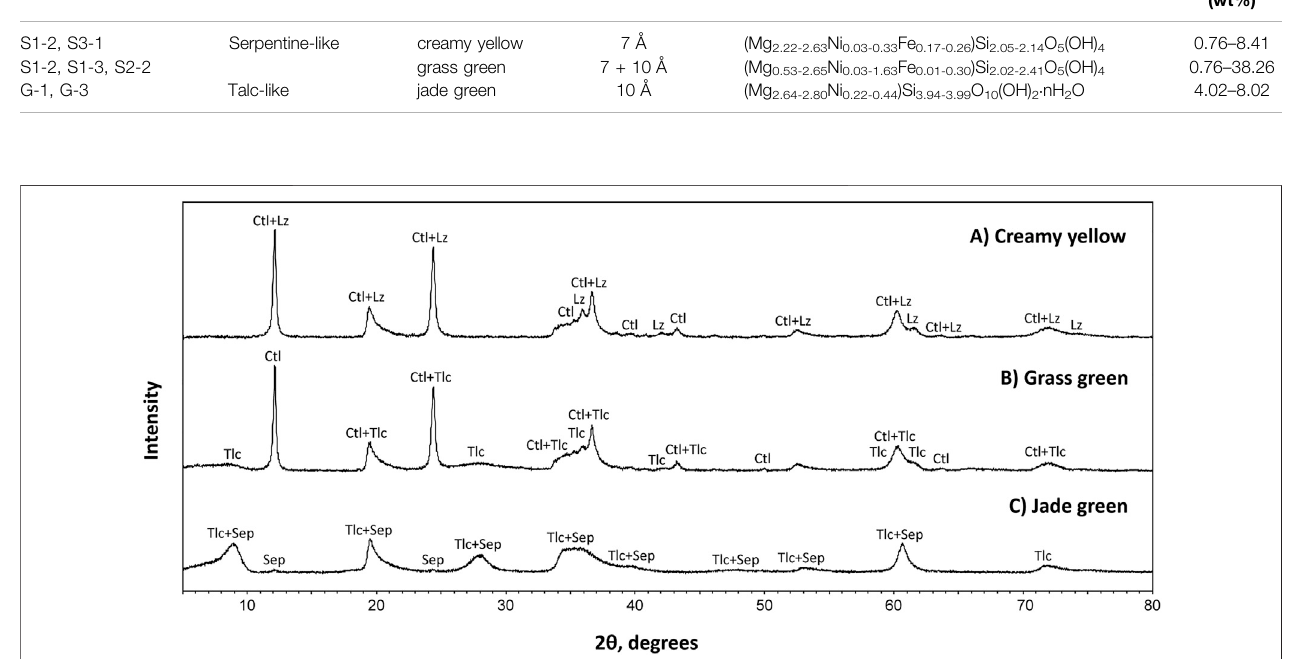
FIGURE4| XRDpatternsofthreegarnieritesamplesfromtheMorowali depositdistinguishedbytheircolors.Unlikethejadegreensample,boththecreamyyellow and grass green samples show similar patterns. However, the grass green sample has a mixed pattern between creamy yellow and jade green samples. Abbreviation: Lz (cid:1) lizardite, Ctl (cid:1) chrysotile, Tlc (cid:1) talc, Sep (cid:1) sepiolite.